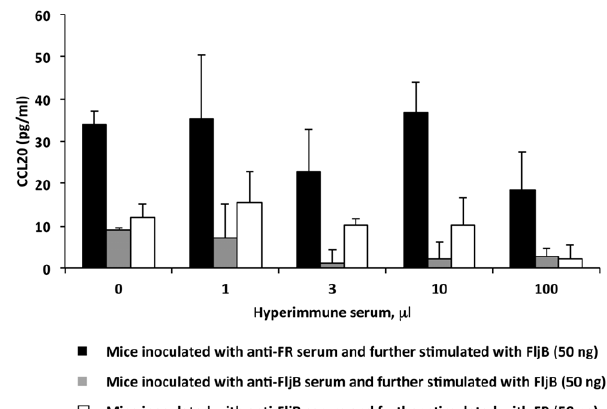
Figure 7. FR flagellin activates the innate immune response in FljB neutralizing mice. CCL20 levels (pg/ml) in sera of FljB- hyperimmunized mice after inoculation with 4.8 m g of FR, FljB or Vibrio vulnificus (Vvul or FlaB) flagellins. Positive control, 71 pg of CCL20. Negative control, two naı¨ve-pooled mice. *, differences in the CCL20 amounts induced by FR and Vvul were statistically significant with respect to FljB, and the higher CCL20 expression induced by FR with respect to Vvul was also statistically significant at the p # 0.05